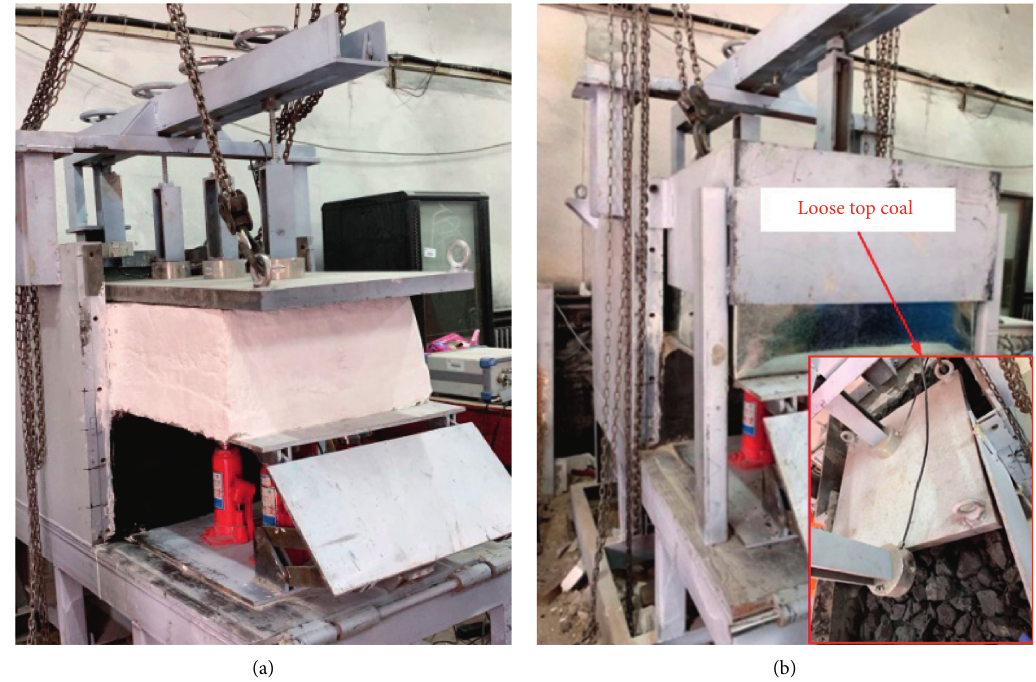
Figure 3: The constructed physical models: (a) large-cutting-height model; (b) top-coal-caving